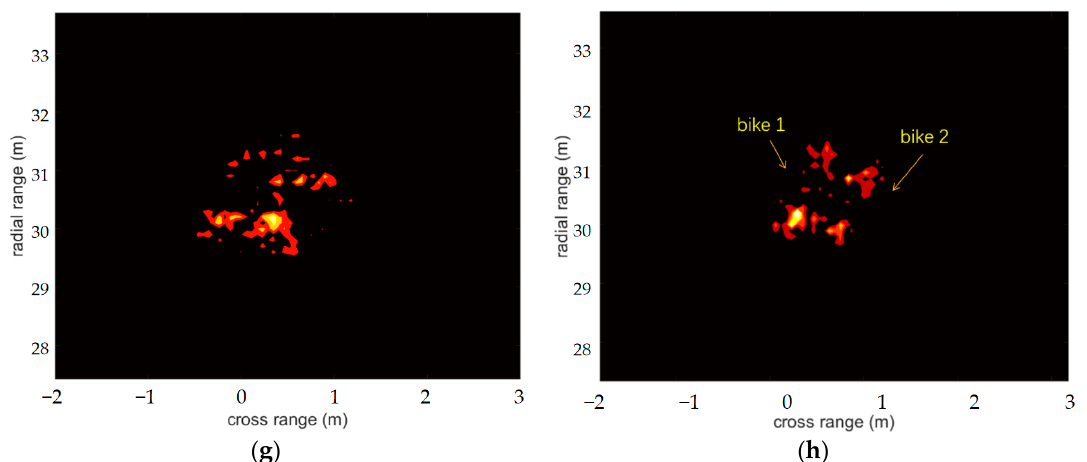
Figure 7. Scene two: ( a ) photograph of distributed radar system, ( b ) photograph of two bikes, ( c ) single-radar SBL imaging result. Zoomed-in imaging of targets with the single-radar system and SBL algorithm ( d ), distributed radar system and FIAA algorithm ( e ), distributed radar system and OMP algorithm ( f ), distributed radar system and S-ESBL algorithm ( g ) and distributed radar system and LC-SBL algorithm ( h ).